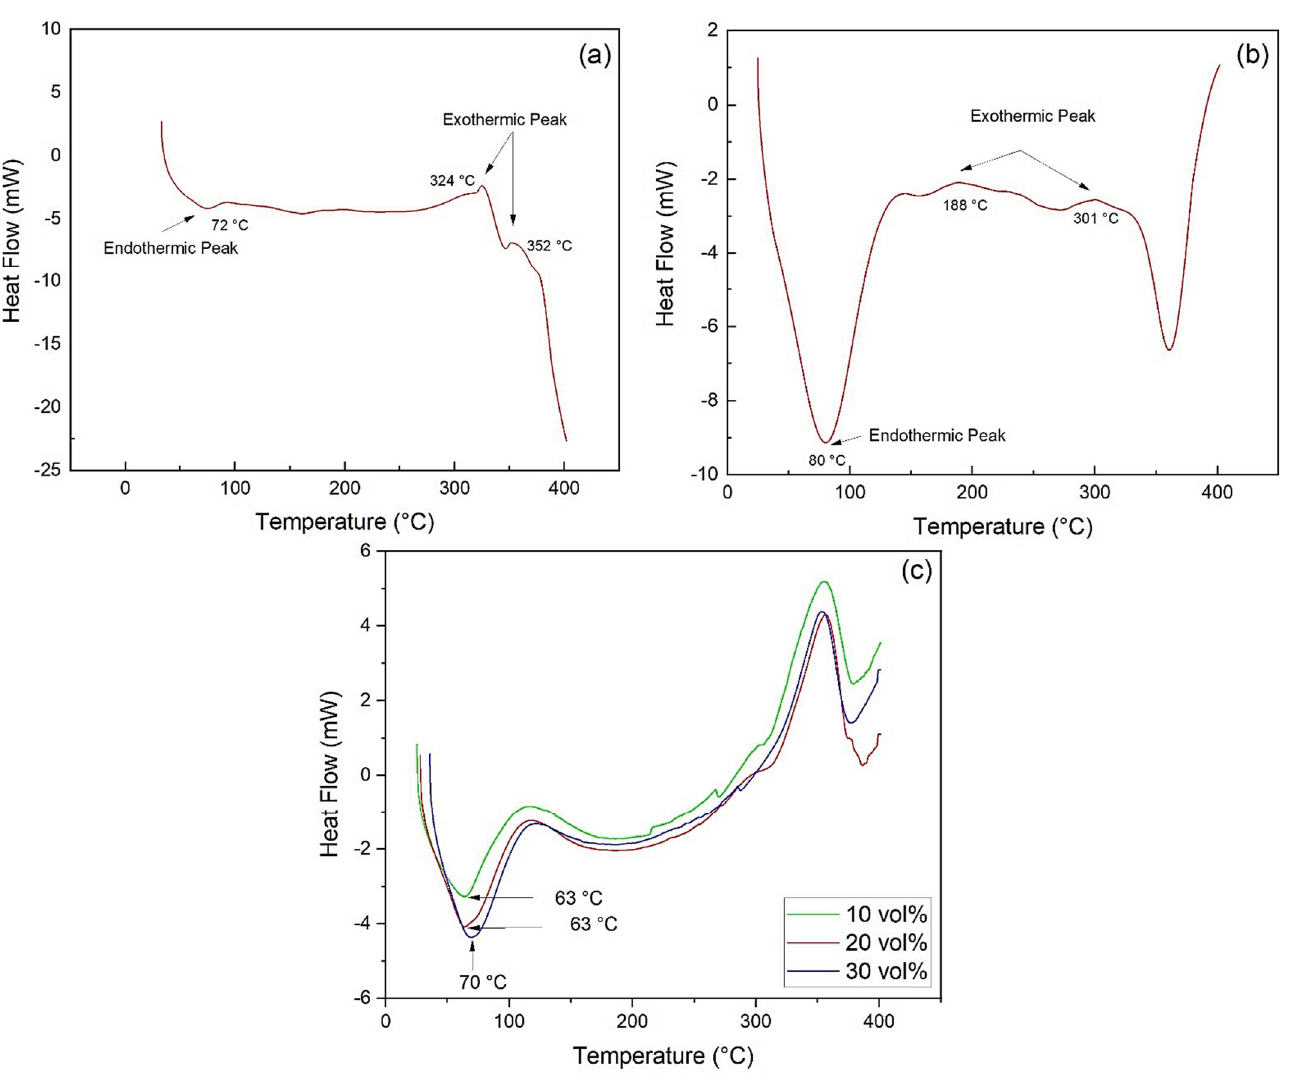
Figure 7. DSC curves: ( a ) epoxy resin; ( b ) kenaf fiber; ( c ) kenaf composites.